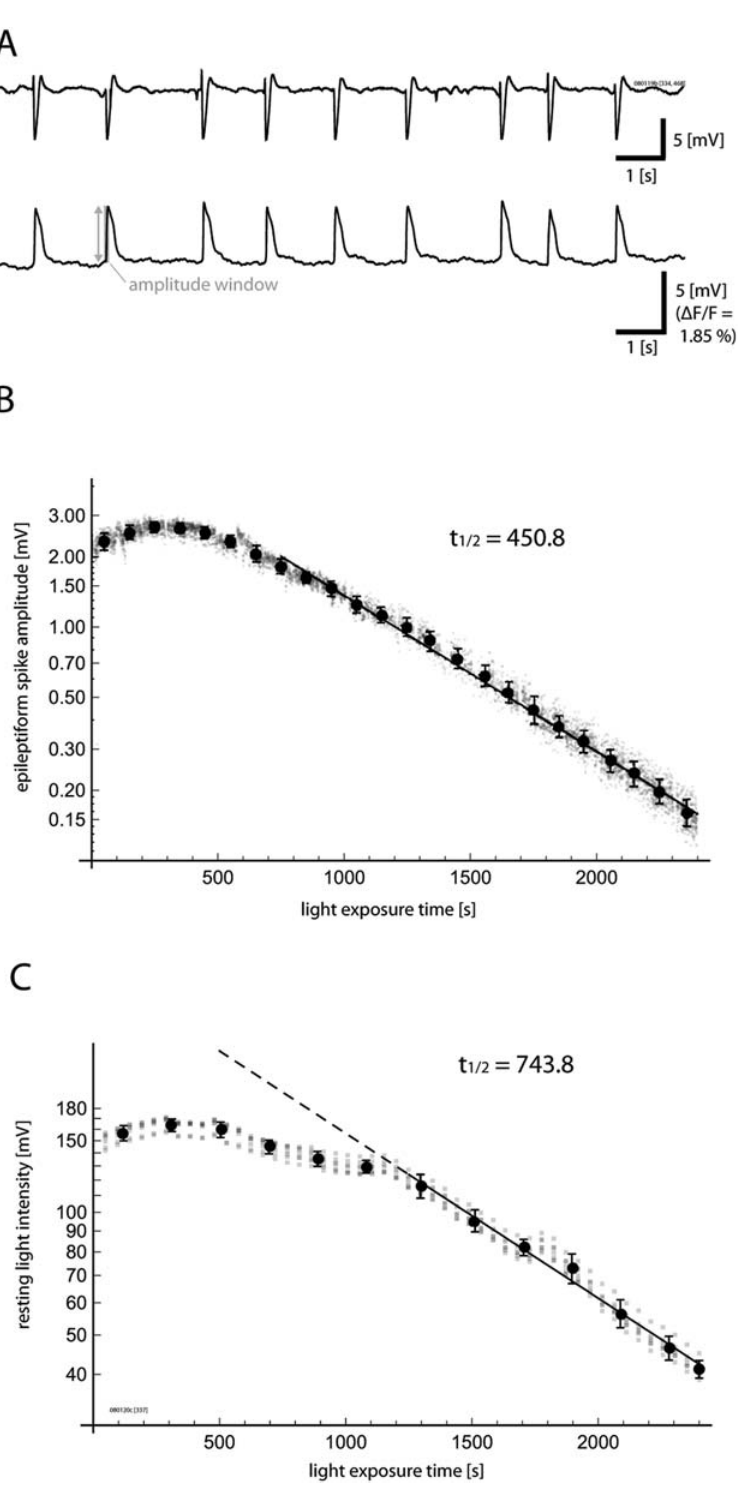
Figure 2. Functional signal ( D F) and total fluorescence (F RLI ) can show different bleaching kinetics. A. Stable, spontaneous, epileptiform spikes induced by incubation with bicuculline methiodide. The upper trace shows ECoG recording, and the lower trace shows voltage-sensitive dye fluorescence from a single detector. B. Amplitudes of photocurrent-evoked voltage from epileptiform spikes ( D F epileptiform ) were measured over time in a hexagonal array of seven detectors at the center of the imaging field. Each small gray dot indicates a single spike measurement from a single detector, and aggregate means and standard deviations with 100 ms bins are superimposed. At first, the signal size increases, and then gradually enters into a phase of exponential decline, This complex trend is referred to in this report as ‘‘bleaching,’’ with quotation marks. C. The time course of resting light intensity (F RLI ) is displayed in the same manner. While the overall trend of this measure is similar to that of epileptiform spike amplitude with an early rise and subsequent exponential decay, the transition point between these two phases and the bleaching kinetics differ. The time constant of the later exponential phase is also slower for the resting light intensity ‘‘bleaching.’’ These differences in kinetics suggest a limitation of the standard D F/ F RLI normalization.